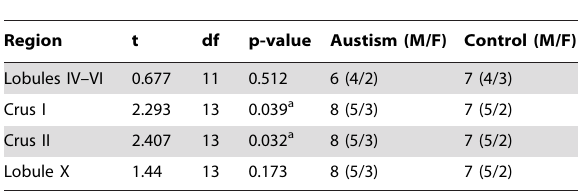
Table 3. Regional Differences in Purkinje Cell